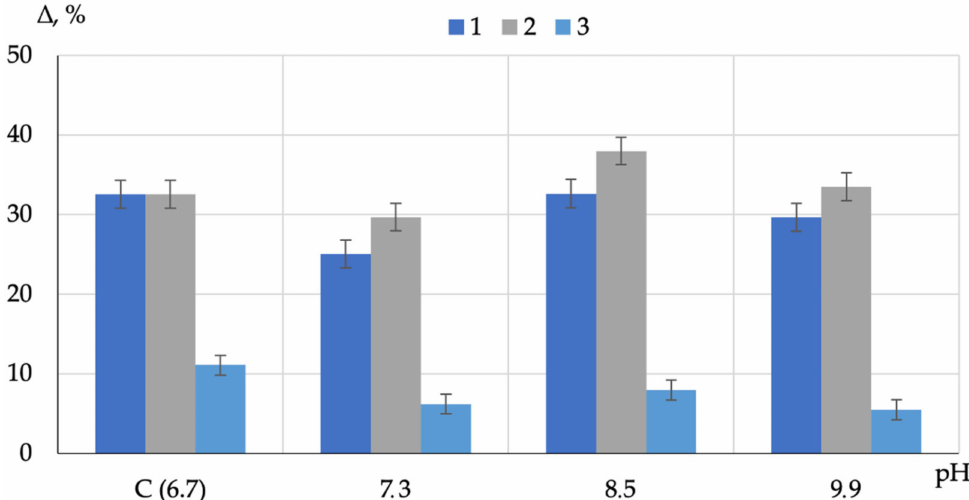
Figure 7. Dependence of the difference between the elastic moduli of different layers of variatropic Figure 6. (C is the control composition; ∆ is the value of the change in the coefficients of the strength variatropic